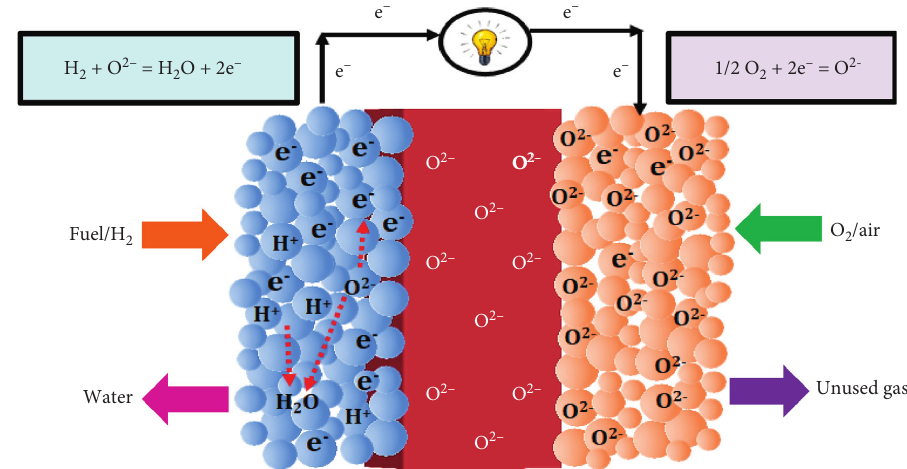
Figure 3: Schematic representation of a solid oxide fuel cell (SOFC)